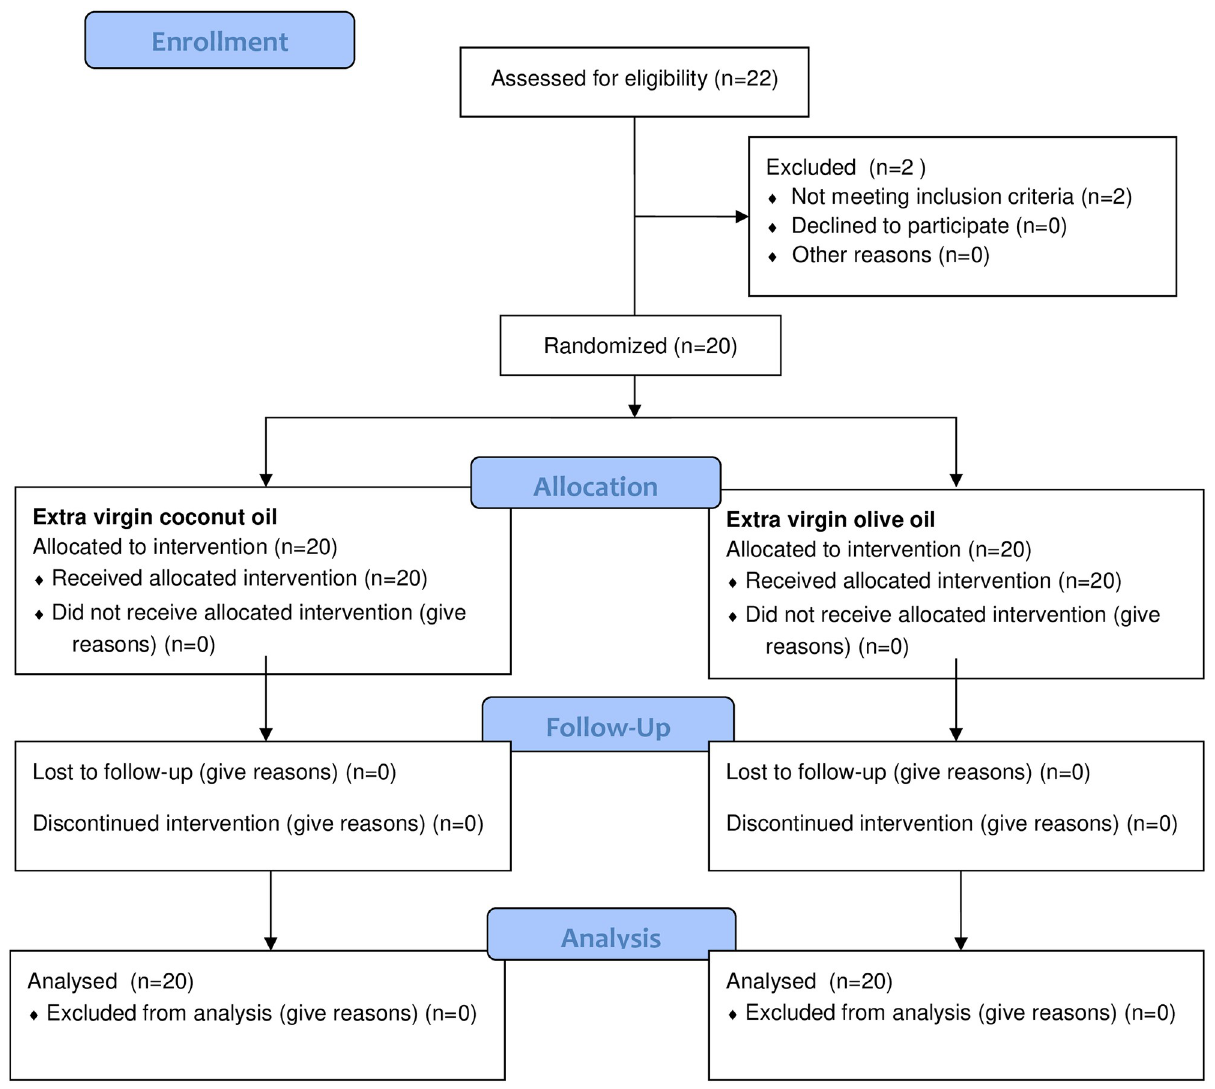
Fig 1. Flow diagram showing process for participants enrollment and